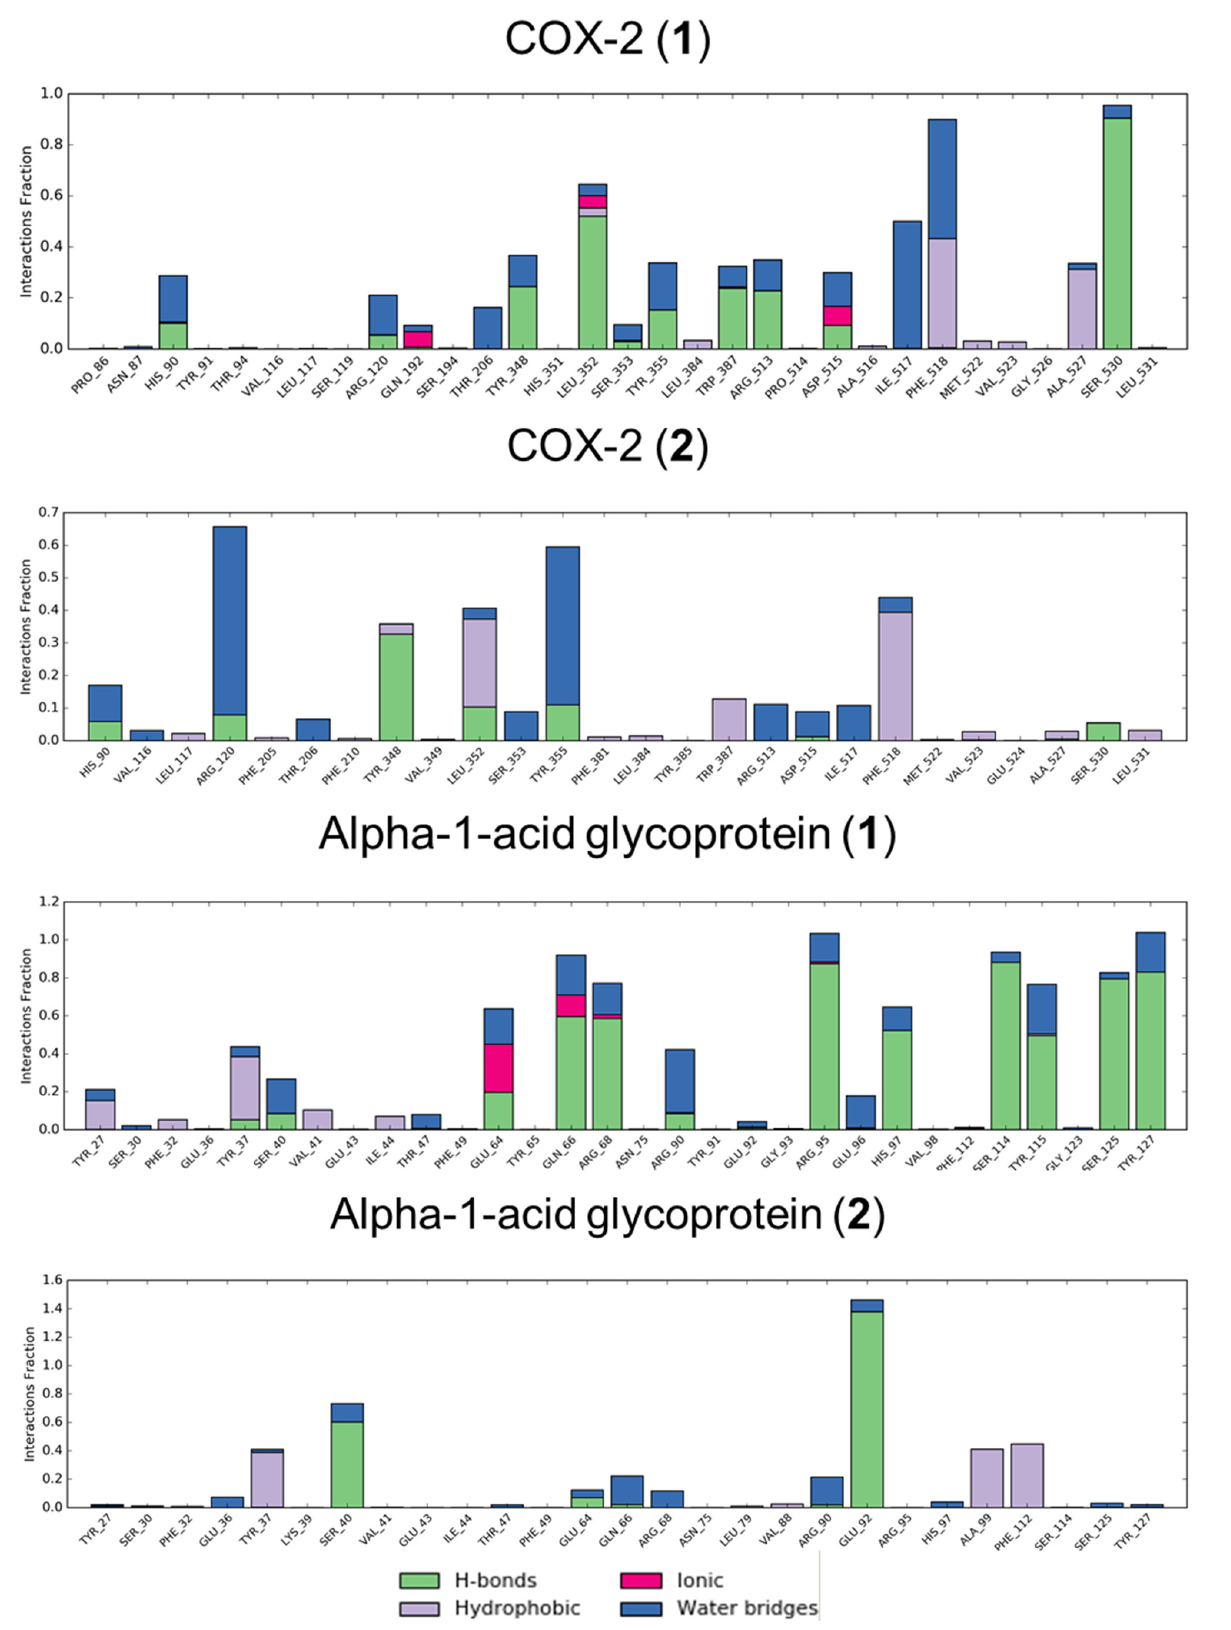
Figure 9. Protein–ligand interactions made by the six complexes during the 100 ns molecular dynamics simulation. The entity of the binding is expressed as fraction of the total simulation time and the different contributions are listed with different